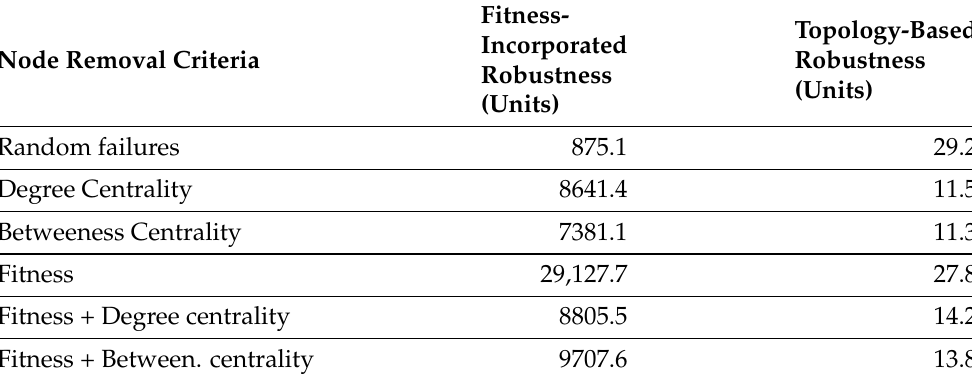
Table 2. Robustness analysis of the Erd˝os–Rényi random network topology with 100 nodes and 300 links, under different attacks.